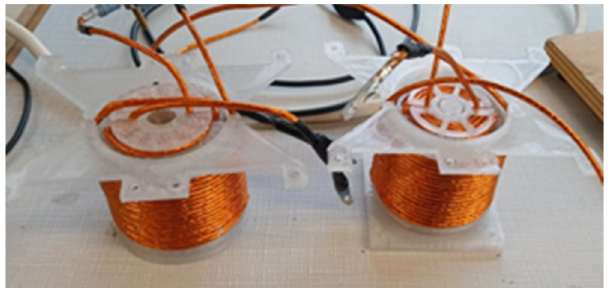
Figure 18. Air-core transformer: Left: Natural convection; Right: Air-forced convection.